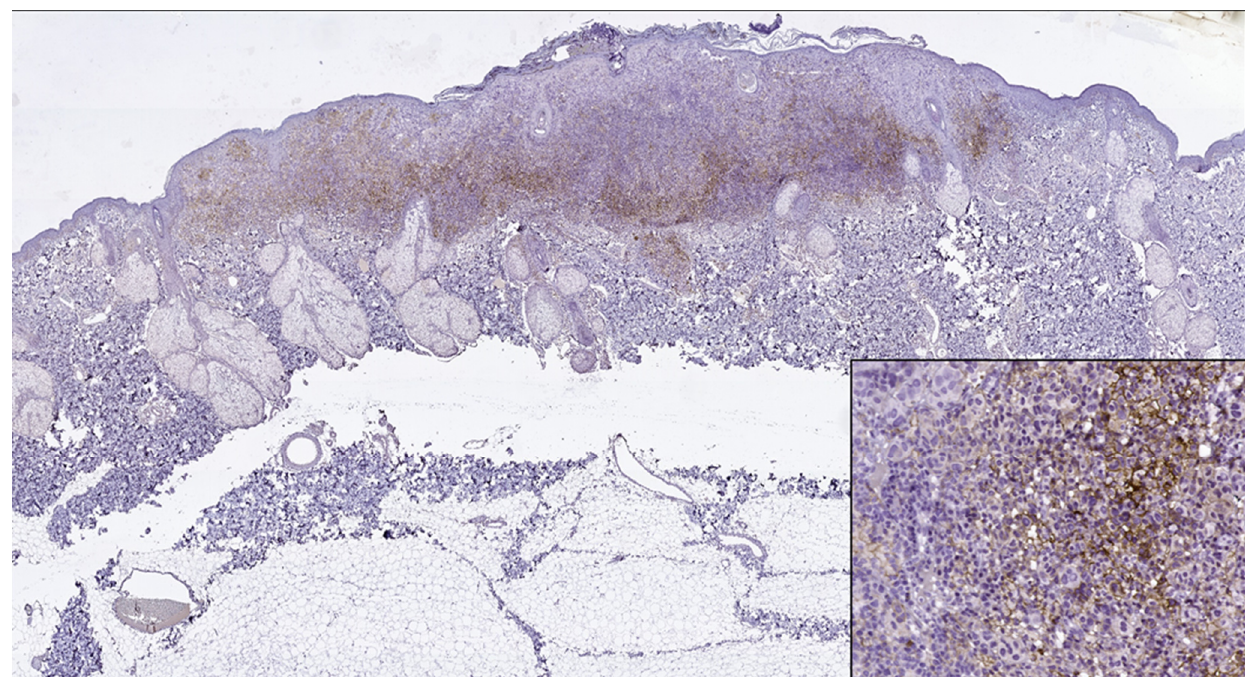
Figure 4. PD ‐ L1 positive expression in melanoma cells of a superficial spreading melanoma (PD ‐ L1 Monoclonal Antibody, Clone CAL10). Lower right side, detail, ob.x200.